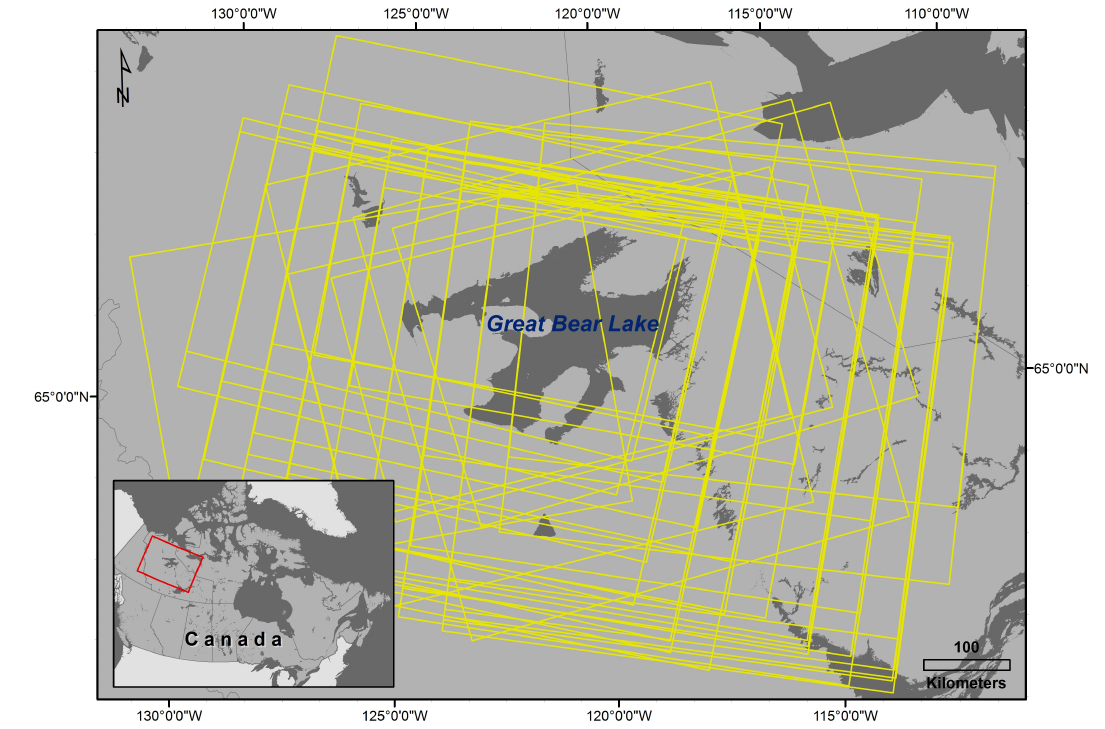
Figure 1. Location of Great Bear Lake within Canada. Footprints of the 36 RADARSAT-2 scenes used in this work are shown in